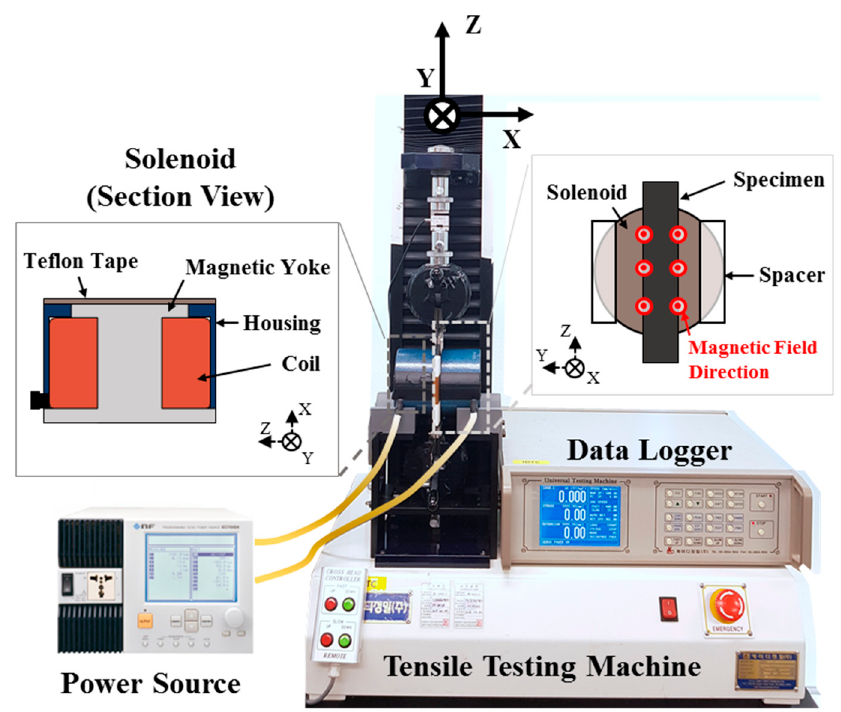
Figure 7. Tensile testing machine with the magnetic core structure.